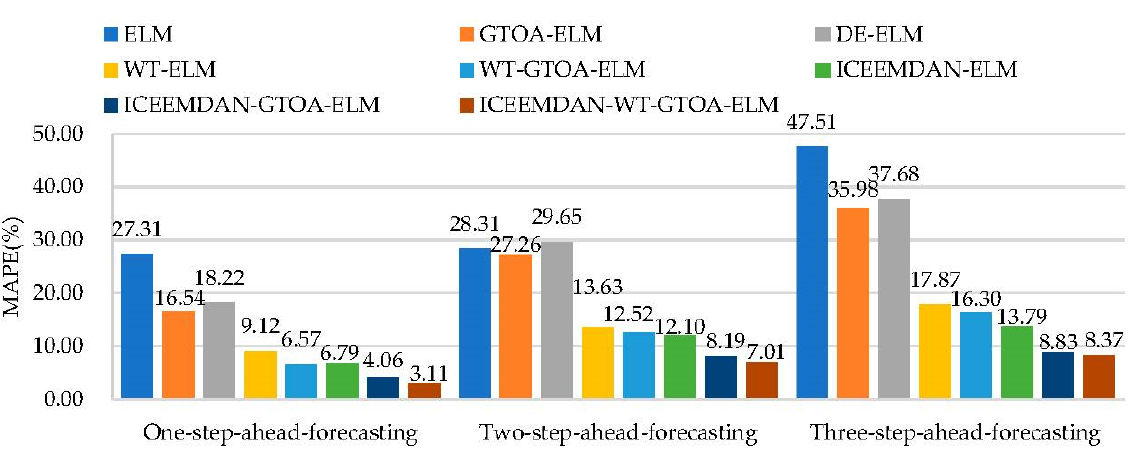
Figure 5. Mean absolute percentage error (MAPE) of PM10 forecasting.